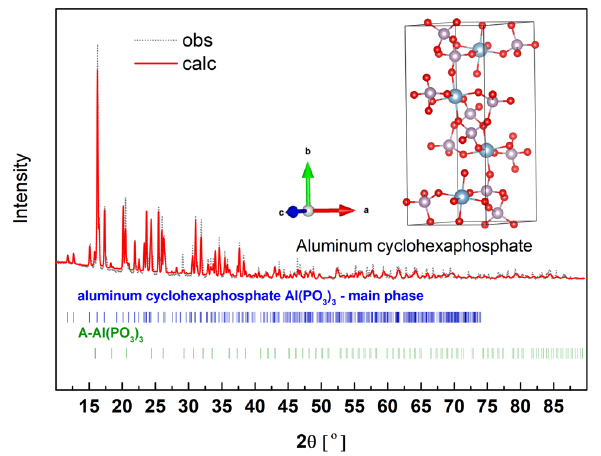
Figure 9. X-ray diffraction pattern (obs) and the fitted (calc) of aluminum cyclohexaphosphate -Al(PO 3 ) 3 . In the inset, the unit cell of the compound with the optimized atom positions.